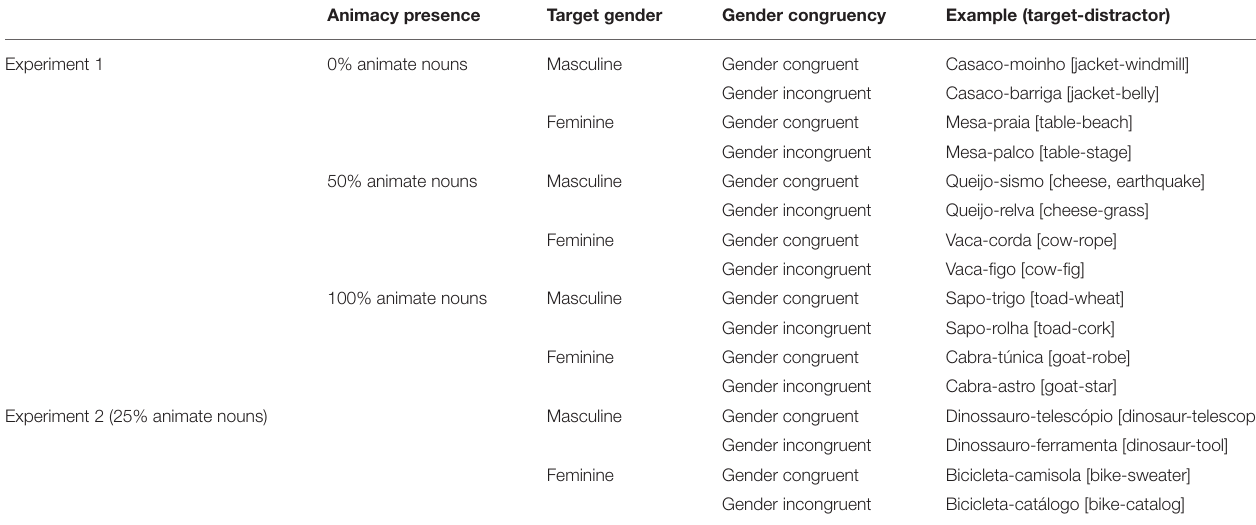
TABLE 1 | Conditions in each of the